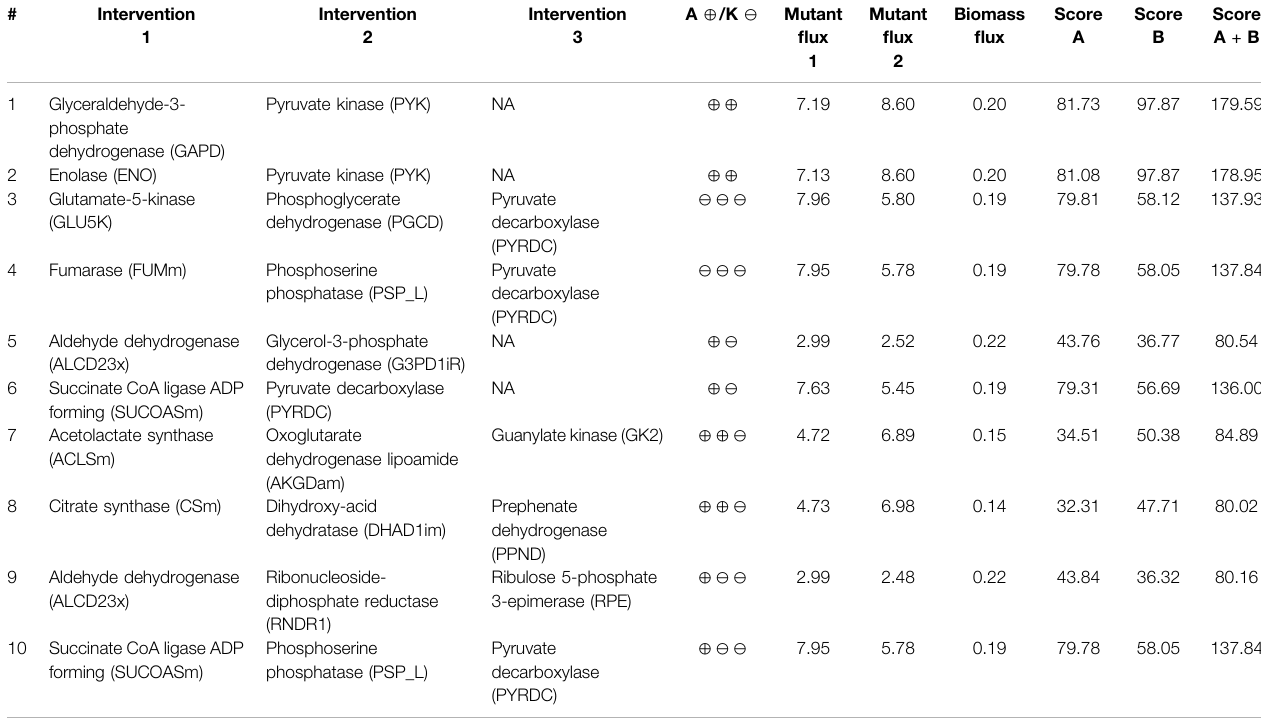
TABLE 5 | Higher-order intervention strategies for co-production of isobutanol and succinate in S. cerevisiae under aerobic